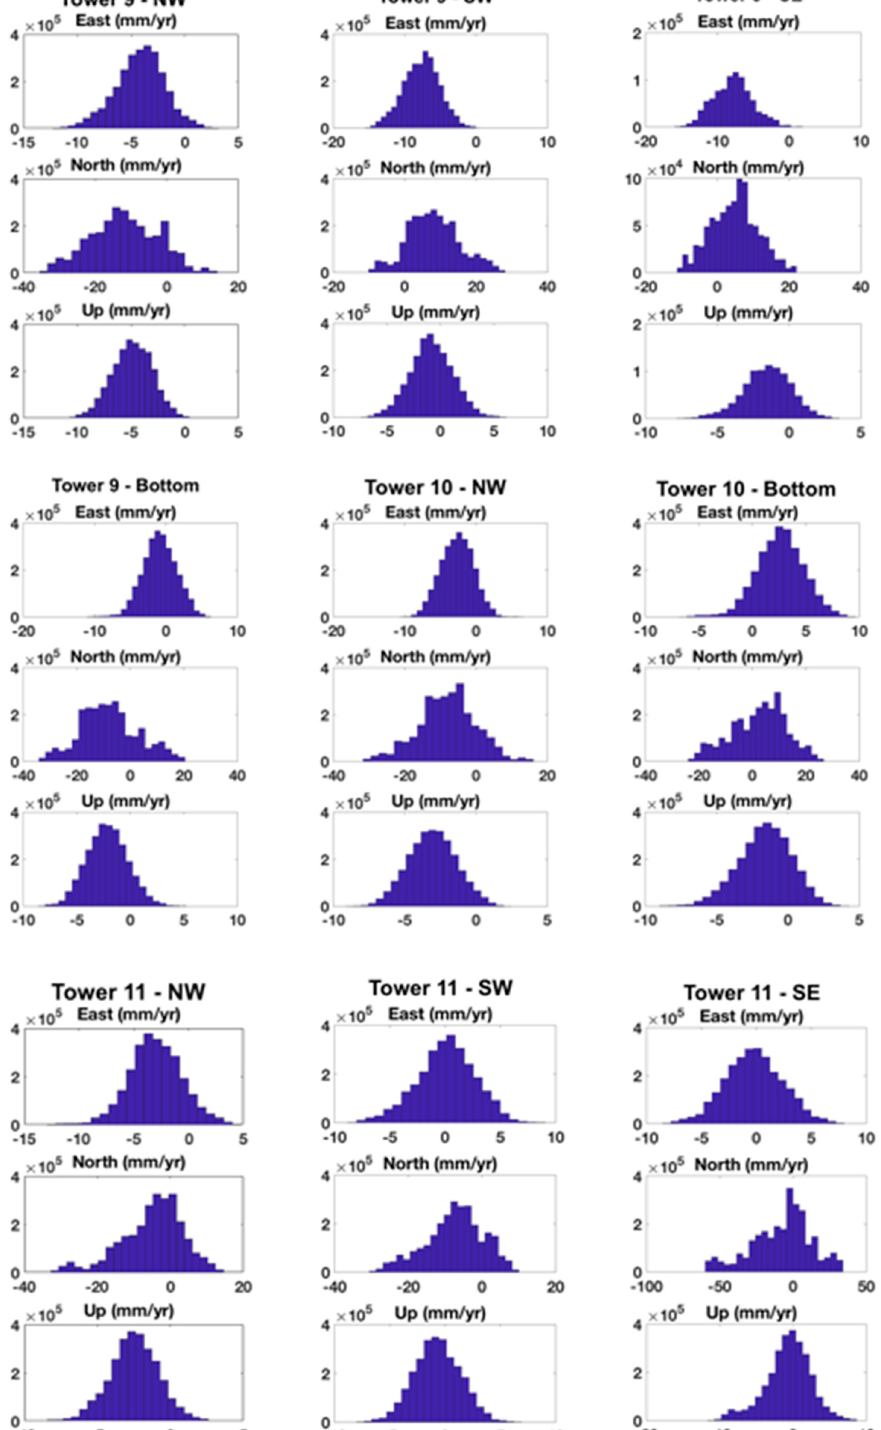
Figure 2. Probability histograms for the Morandi bridge decks 9–11. Markov chain Monte Carlo (MCMC) histograms output inferring three-dimensional deformation fields. LOS displacement rates used as inputs are listed in Table 2.